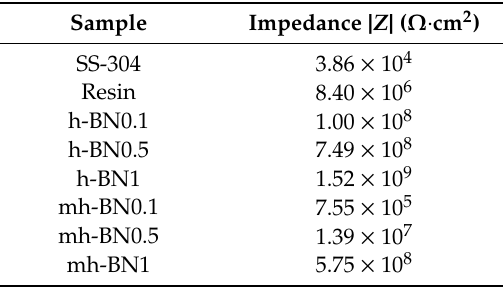
Table 3. Impedance | Z | at low